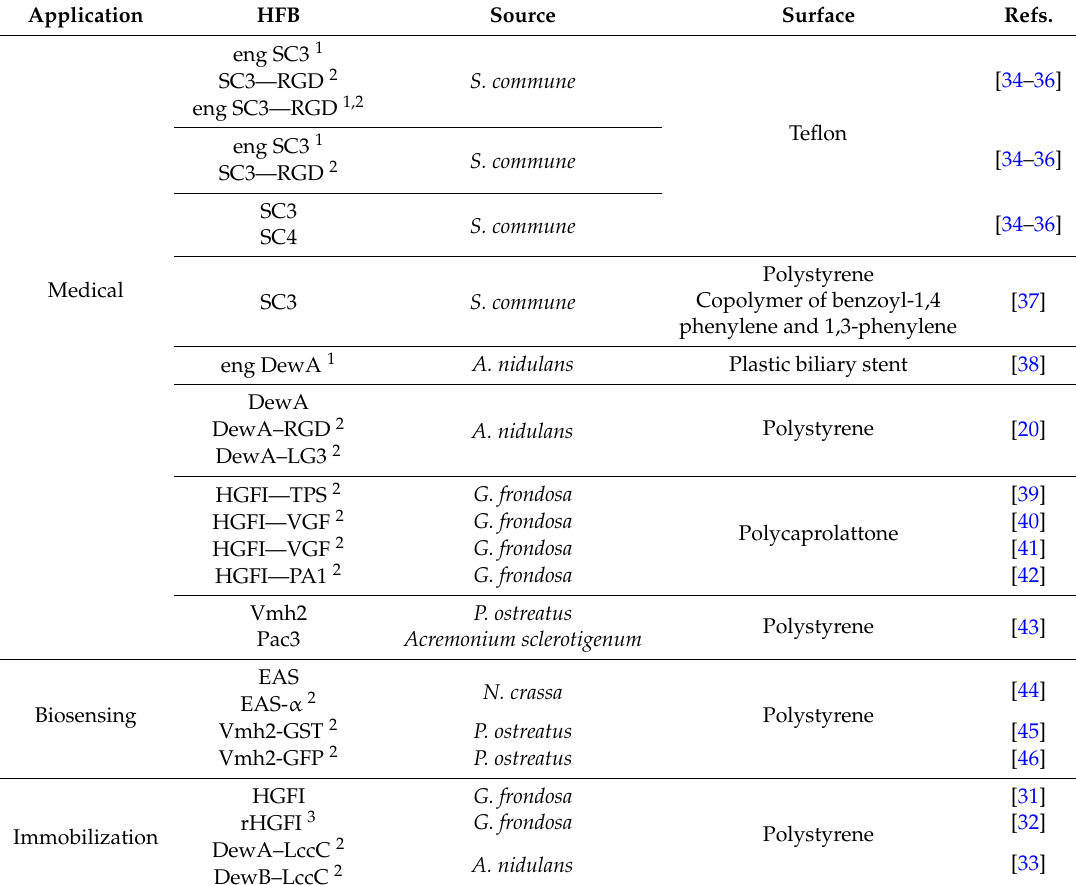
Table 1. Class I hydrophobins used in functionalization of plastic